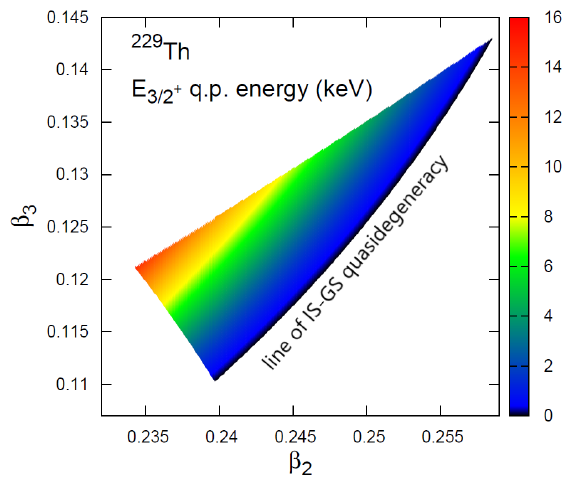
Figure 2. Q.p. energy (in keV) of the 3 / 2 + isomer orbital with respect to the 5 / 2 + GS orbital appearing in DSM within the model-defined space of QO